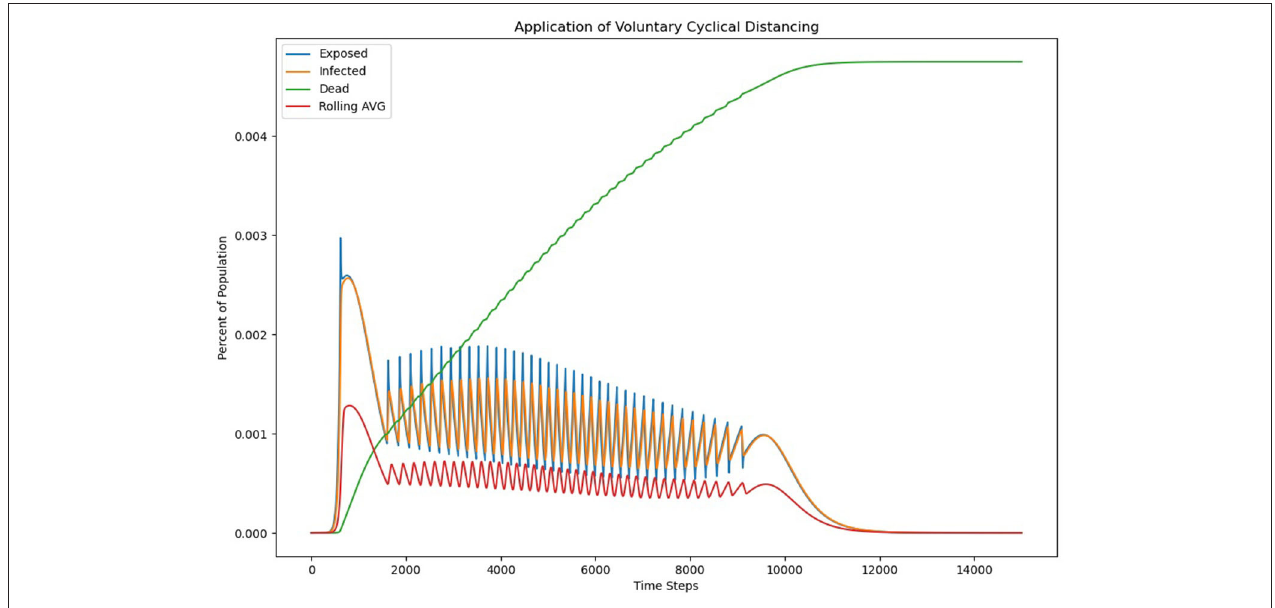
FIGURE 3 | Application of voluntary cyclical